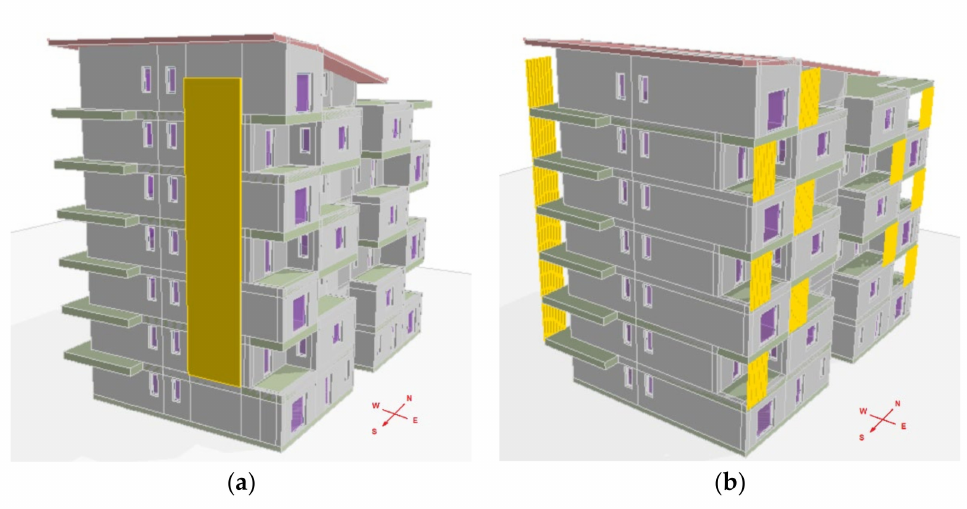
Figure 11. Architectural integration with ( a ) glazed flat solar collectors on the south wall and ( b ) vacuum solar collectors as active shading elements for the windows exposed to East and